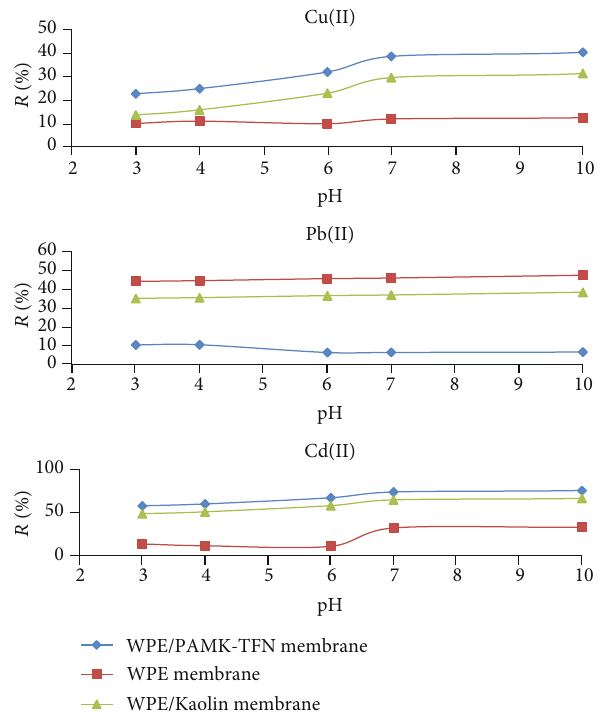
Figure 15: E ff ect of pH value on the rejection of heavy metals on the prepared WPS, WPS/kaolin, and WPE/PAMK-TFN membranes.